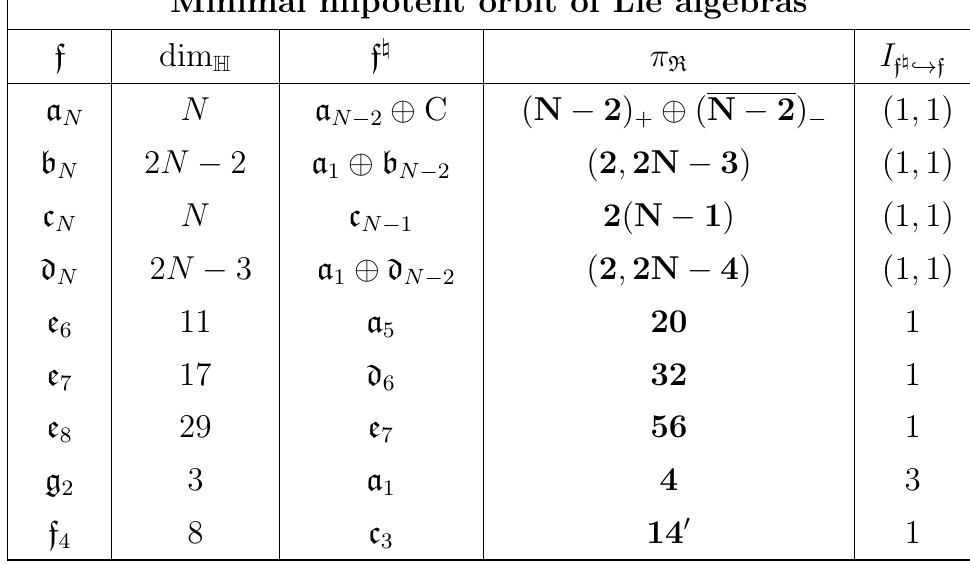
Table 4 . Properties of minimal nilpotent orbits of classical and exceptional Lie algebras. The first column indicates the lie algebra f , the second the quaternionic dimension of the orbit, the third the stabilizer group of a generic non-singular point of the orbit f \ . Finally the last two columns indicate the represenation of the goldstone bosons under f \ and the index of embedding of f \ , → f . This table is almost verbatim taken from